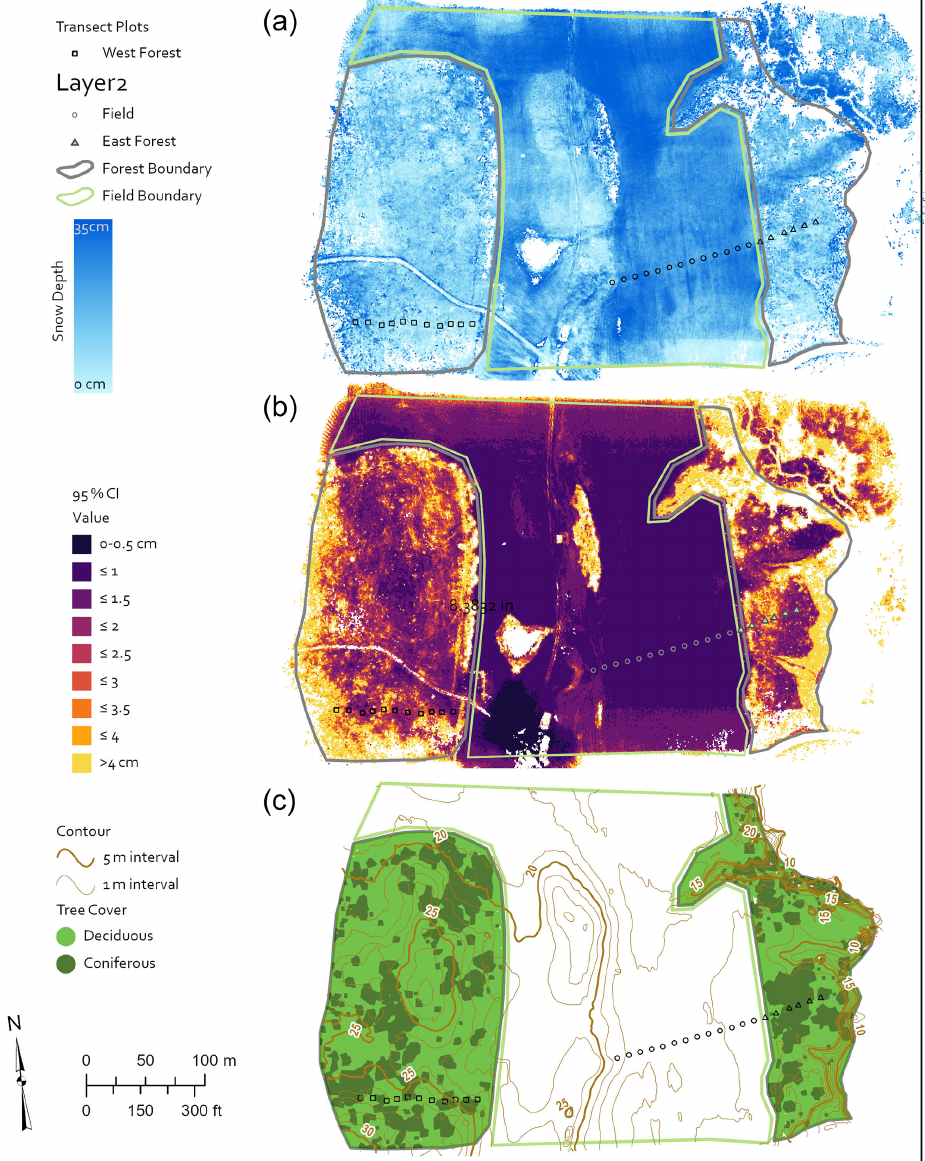
Figure 5. Average (a) snow depth values, (b) one-sided confidence intervals, and (c) topography and forest cover type. Snow depth and confidence intervals calculated from the snow-on and snow-off lidar point clouds for 1m 2 cells at Thompson Farm, Durham, NH. Topography and forest cover type determined from snow-off lidar point clouds on snow-off flight for 1m 2 cells conducted on 11 April